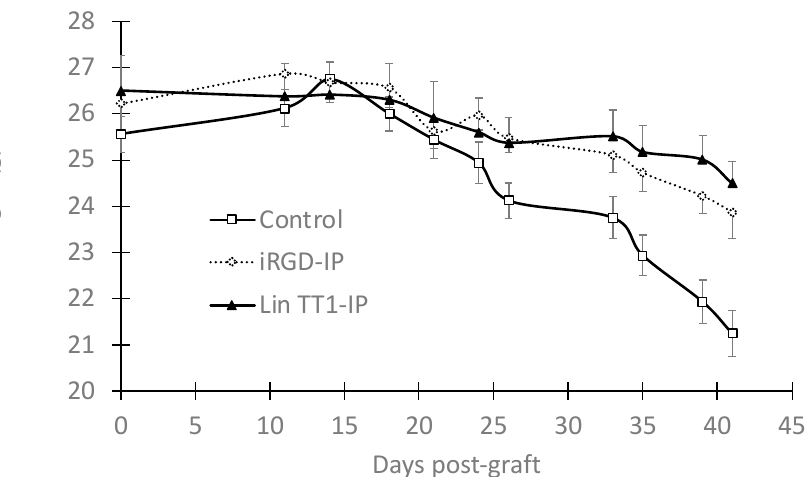
Figure 5. Effect of the peptide on the body weight.